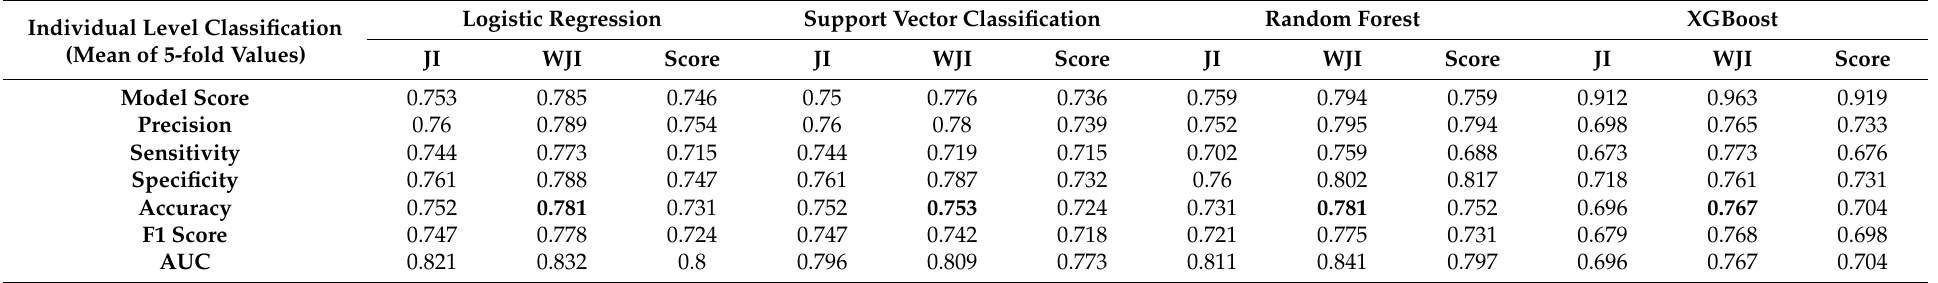
Table 9. Training and verification results of ALS_EG , ALS_CG and ALS_SELECT_FEA 0.1 (individual level classification).